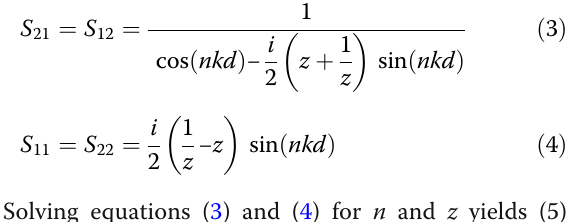
Solving equations (3) and (4) for n and z yields (5) and (6) [9]: